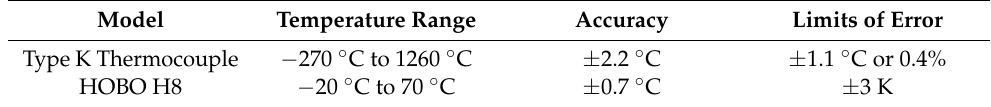
Figure 9. Measurement locations. Table 7. The specifications of the equipment.